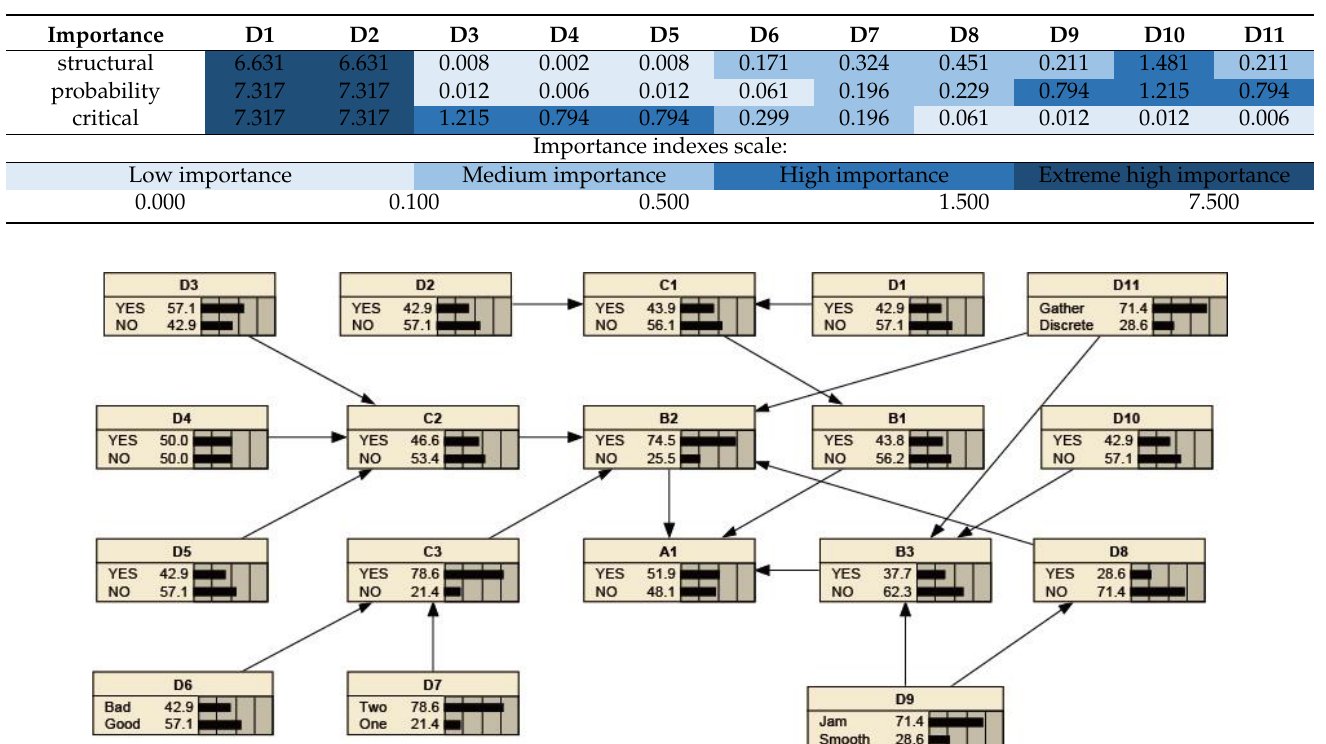
Table 4. Importance index coefficient table.